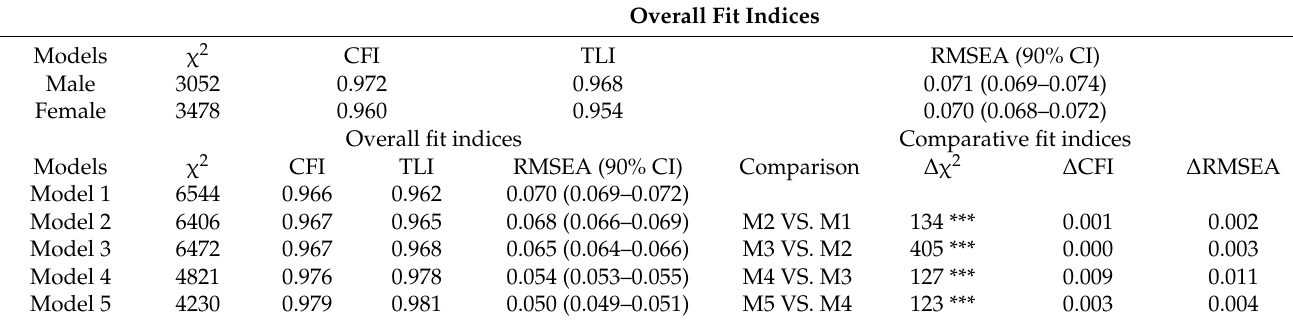
Table 5. Testing for gender invariance: Results of the three-factor model of the DASS. Overall Fit